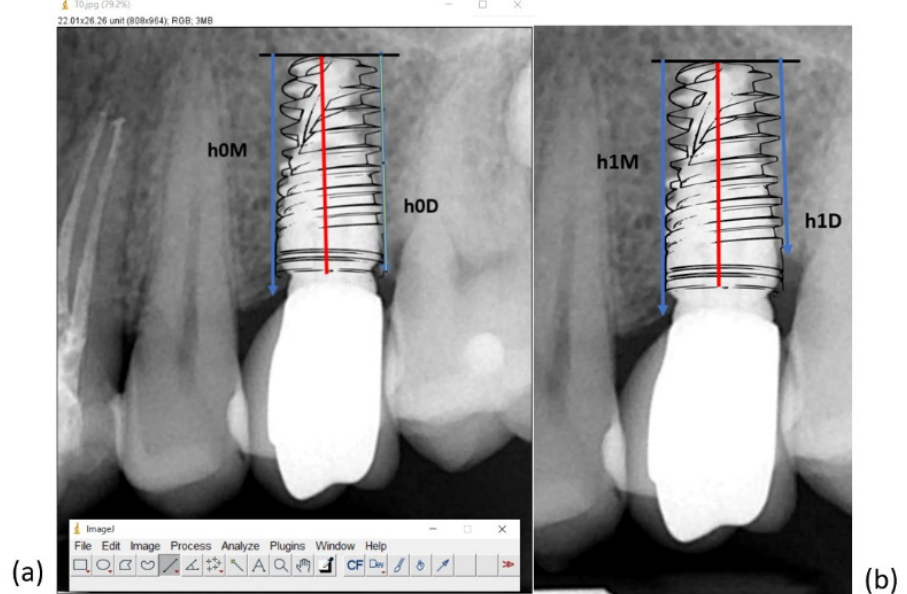
Figure 2. Marginal bone loss calculation taking into consideration: ( a ) mesial and distal bone level at T0 (h0M, ho0D), measured with Image J software, and ( b ) mesial and distal bone level at T1 (h1M, h1D).